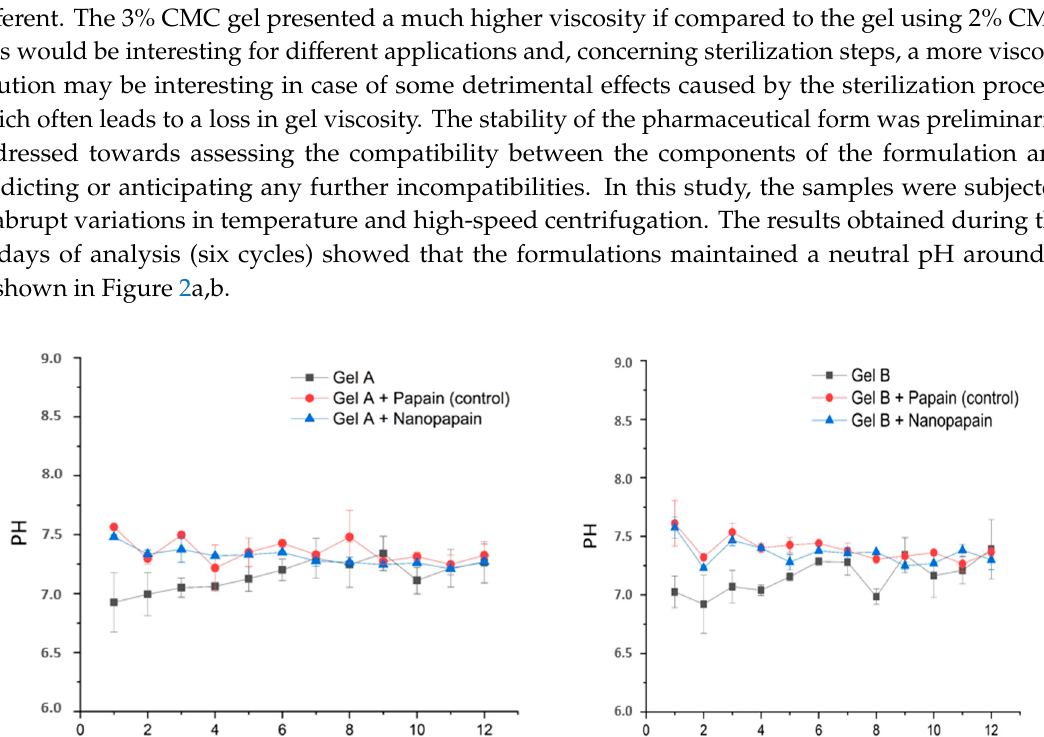
Table 2. Organoleptic properties observed during the stability assessment.